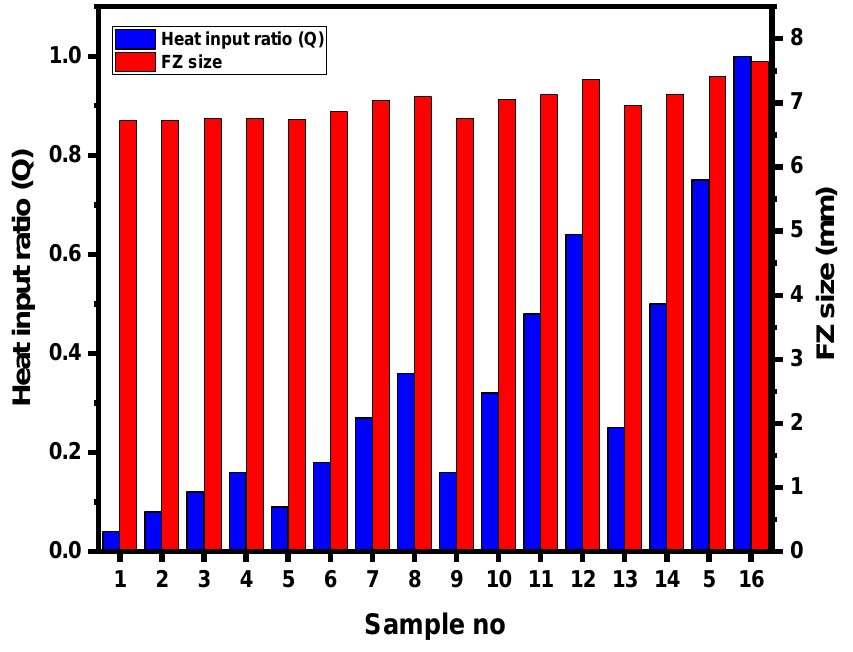
Figure 12. Effect of heat input on FZ size.